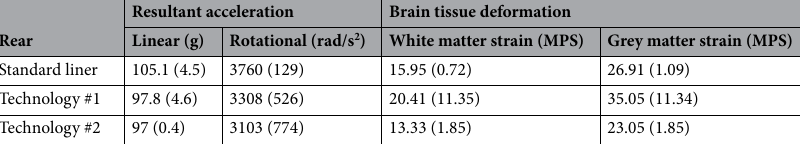
Table 4. Summary table with means of impact variables measured along with the standard deviations in brackets for the rear